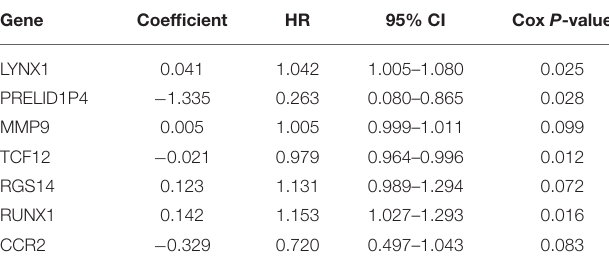
TABLE 2 | The results of the multivariate Cox regression analyses.